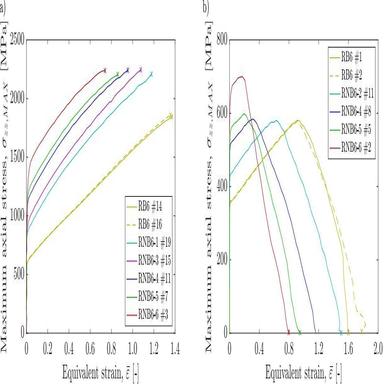
Maximum axial stress - equivalent strain of the RNB tensile tests: (a) stainless steel 304L; (b) copper C110.